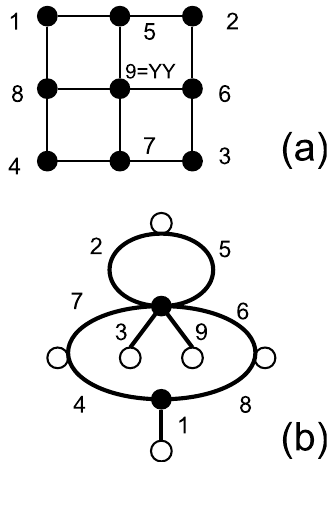
Figure 3. ( a ) The Mermin square, M , and ( b ) its associated dessin d’enfant , D M , with permutation group P = ⟨ (cid:11); (cid:12) ⟩ , where (cid:11) = (3 ; 9 ; 6 ; 5 ; 2 ; 7)(1 ; 8 ; 4)) , (cid:12) = (1)(3)(9)(2 ; 5)(4 ; 7)(6 ; 8) . One has B = 2 black vertices, W = 6 white vertices, N = 9 half-edges, F = 3 faces and genus g = 0